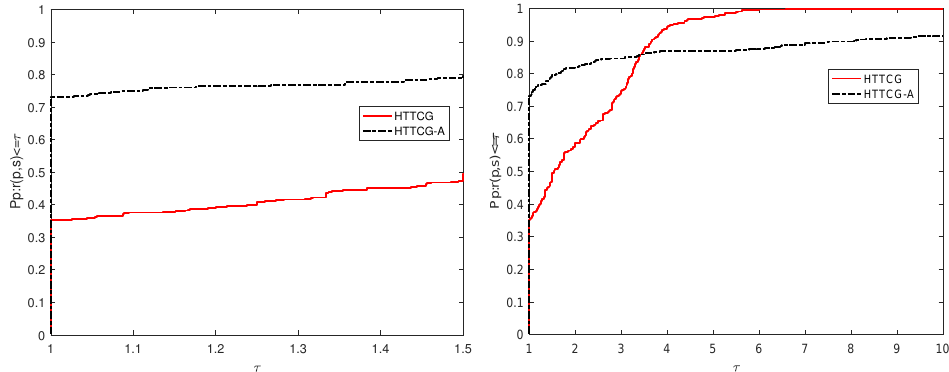
Figure 4. Performance profiles of Algorithm 2 and the acceleration form in NI case.